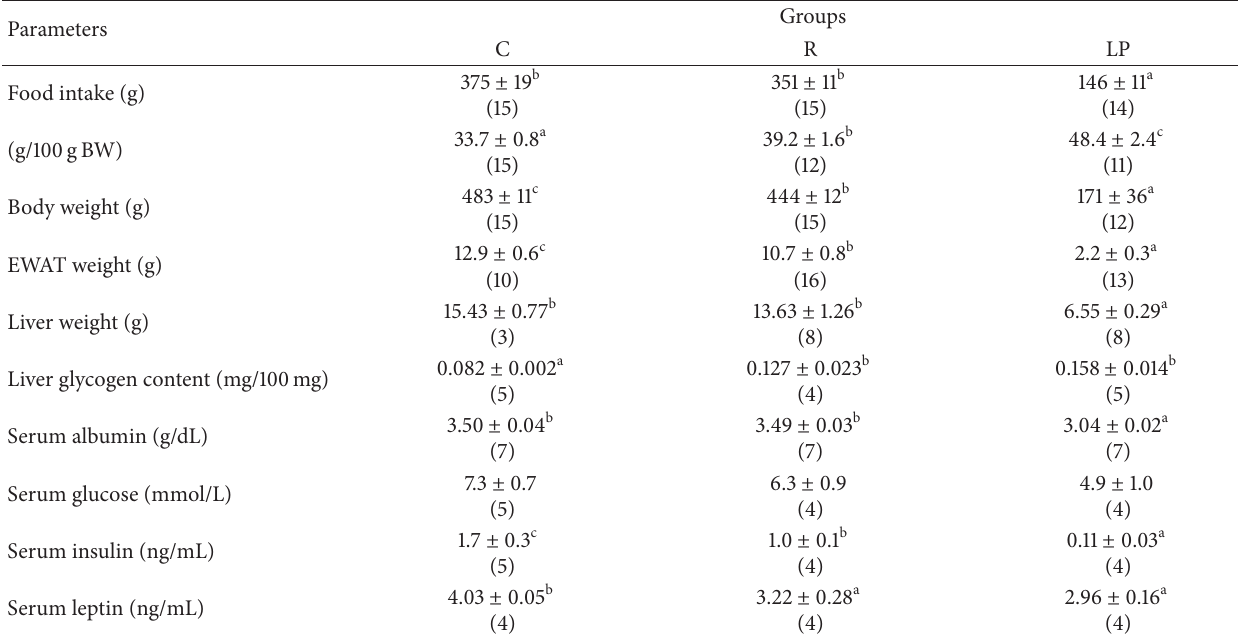
Table 1: Absolute and relative food intake, final body weight, epididymal white adipose tissue (EWAT) weight, liver weight, liver glycogen content, serum albumin, serum glucose, serum insulin, and serum leptin concentrations of control (C), recovered (R), and low protein (LP) rats. Values presented are the mean ± SEM for rats per group. Mean values with unlike superscript letters were significantly different ( 𝑃 < 0.05, LSD